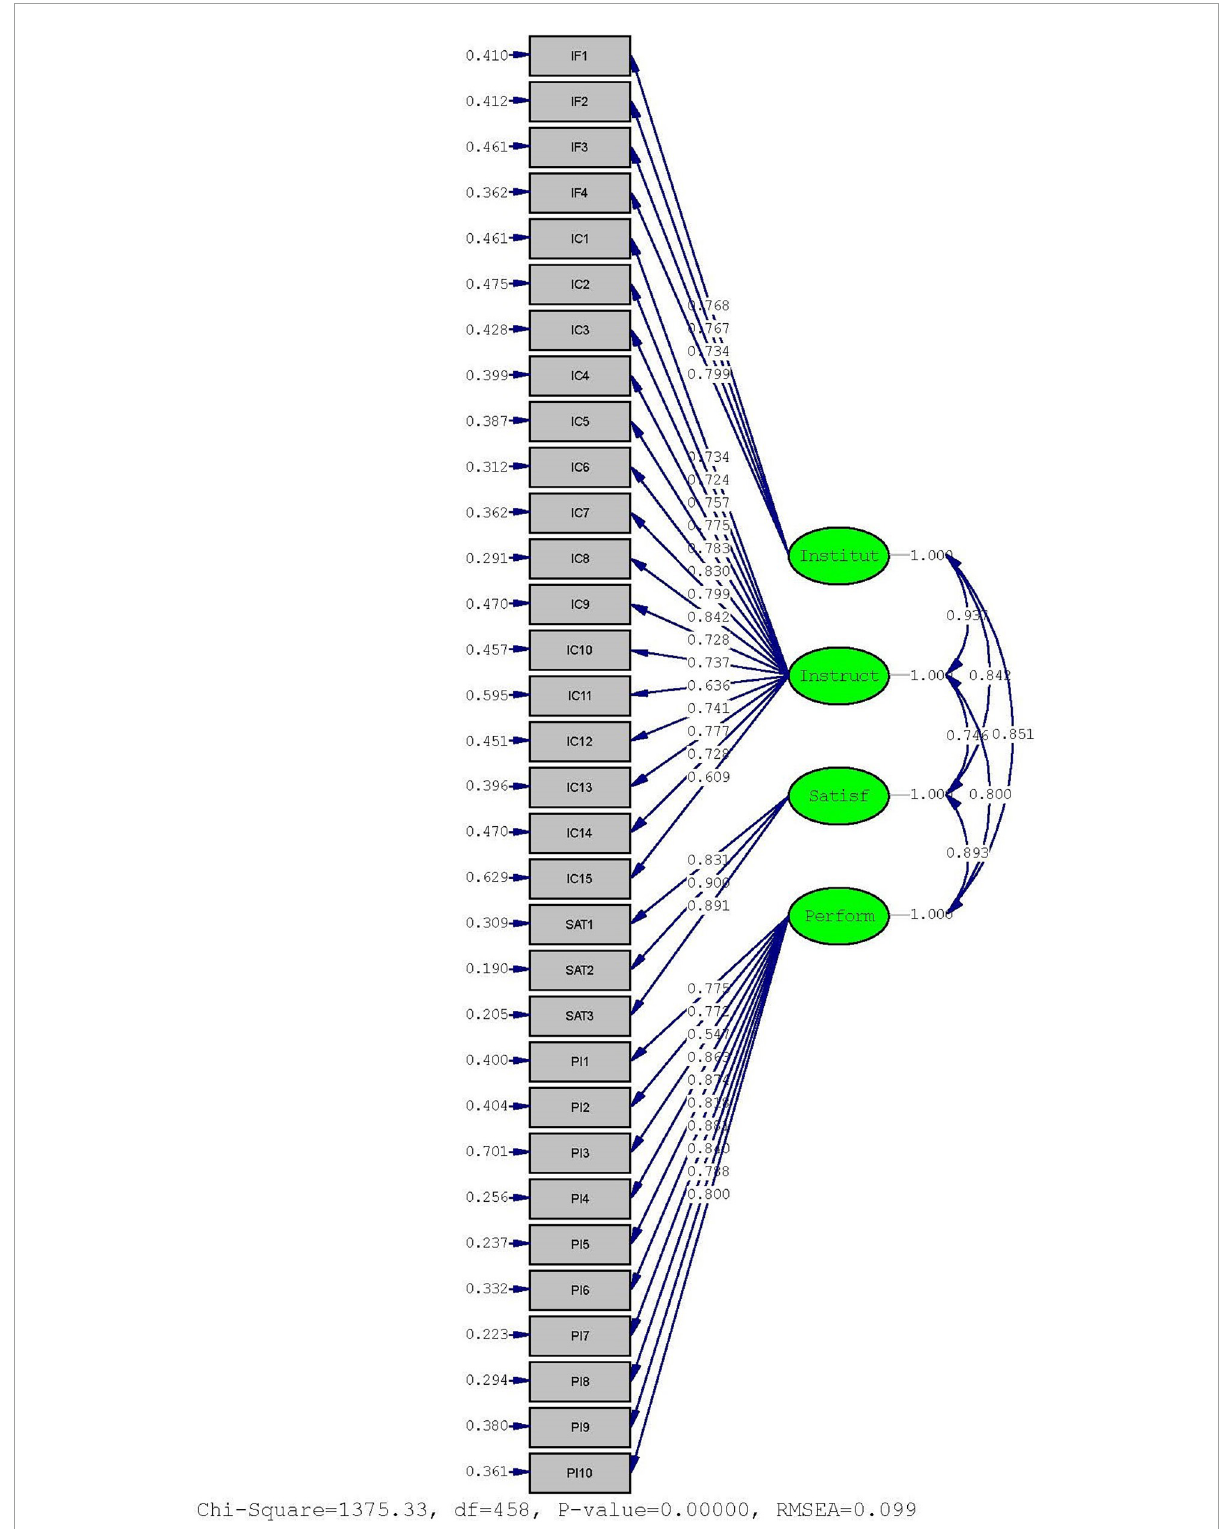
FIGURE3 Validity and reliability (first